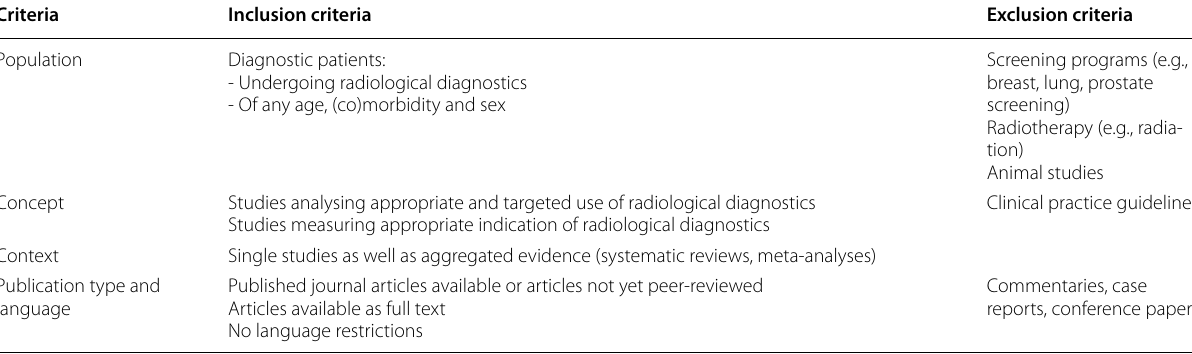
Table 1 Inclusion and exclusion criteria based on the PCC (Population–Concept–Context)